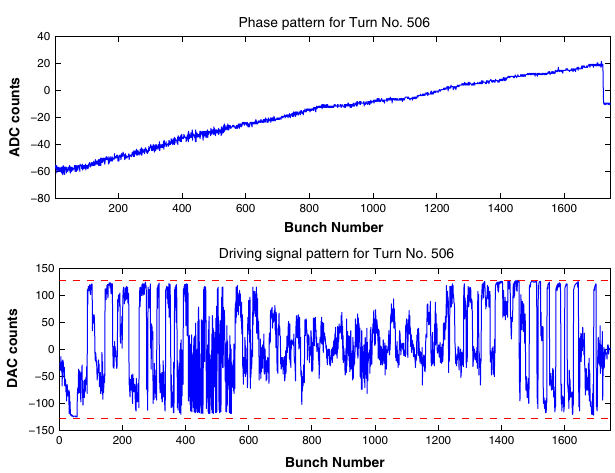
FIG. 12. (Color) Front-end and back-end signal of the longitu- dinal feedback system for turn 506 of the time sequence shown in Figs. 8 and 9. At this moment the kick signal around the turn is hitting both positive and negative saturation, though the average value is close to zero and